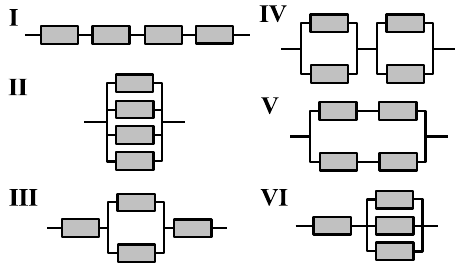
Figure 10. Typical connection of sensitive equipment in process.